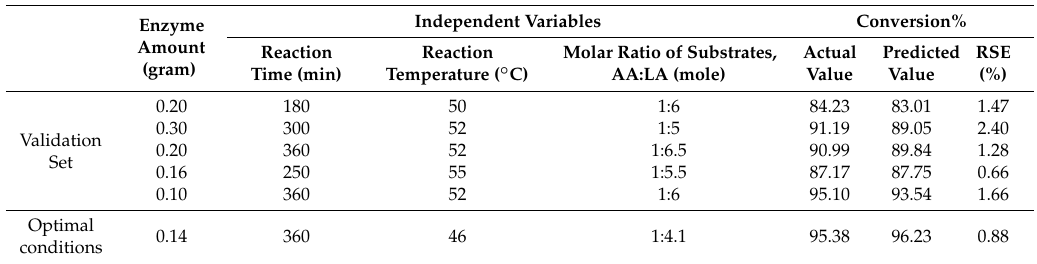
Table 4. Optimum conditions derived by response surface methodology (RSM) and validation set for synthesis of dilaurylazelate